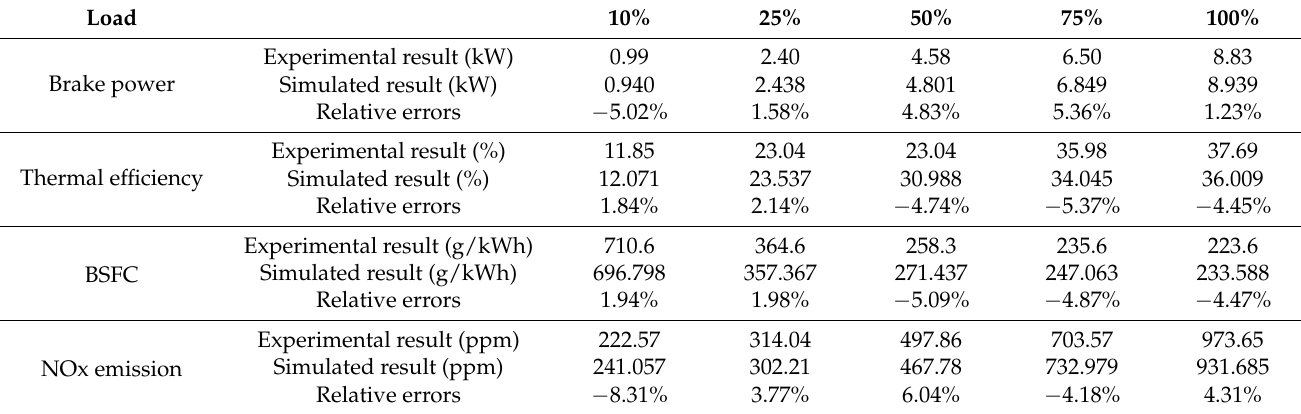
Table 3. Results Validation.